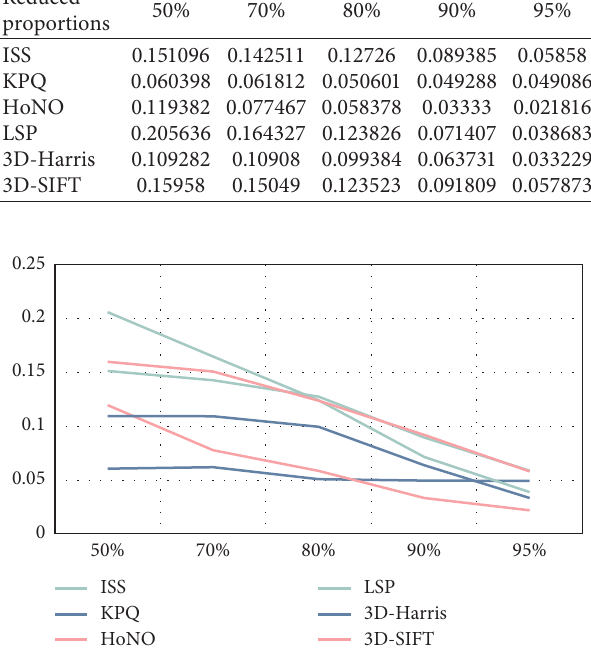
Figure 6: The relationship between the repetition rate and the reduction rate. Table 10: The outlier repetition rate r tection algorithm on the laser scanner data set.